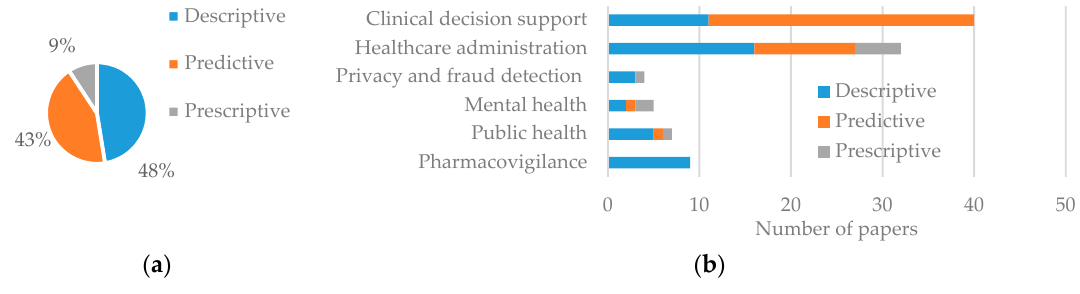
Figure 6. Types of analytics used in literature. ( a ) Percentage of analytics type; ( b ) Analytics type by application area.